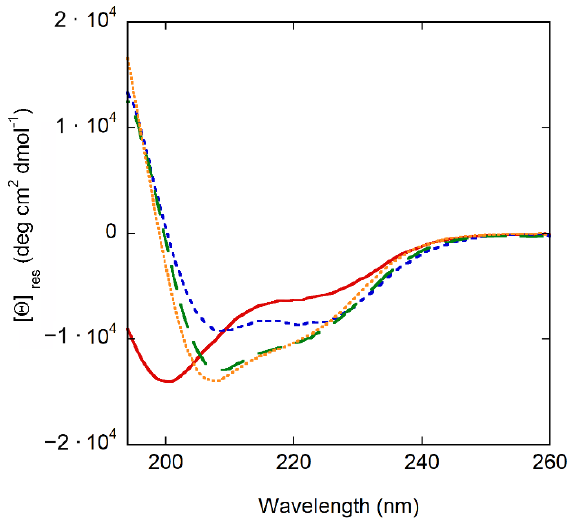
Figure 2. Secondary structure of crabrolin21 in different systems. Far UV circular dichroism spectra of crabrolin21 in aqueous buffer solution (solid red line), methanol (green dashed line), TFE (orange dotted line), and in the presence of POPE/POPG (7:3 molar ratio) at 500 µM total lipid concentration in phosphate buffer (10 mM, pH 6.5) (blue short-dashed line). Crabrolin21 concentration: 11 µ M. Measurements were performed at 298 K and pH